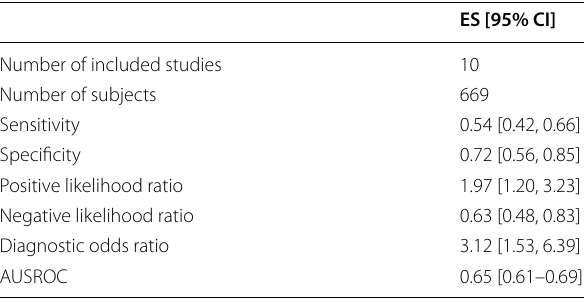
Table 2 Summary of the pooled estimates of studies using APT in comparison to SPT for the diagnosis of patients with atopy